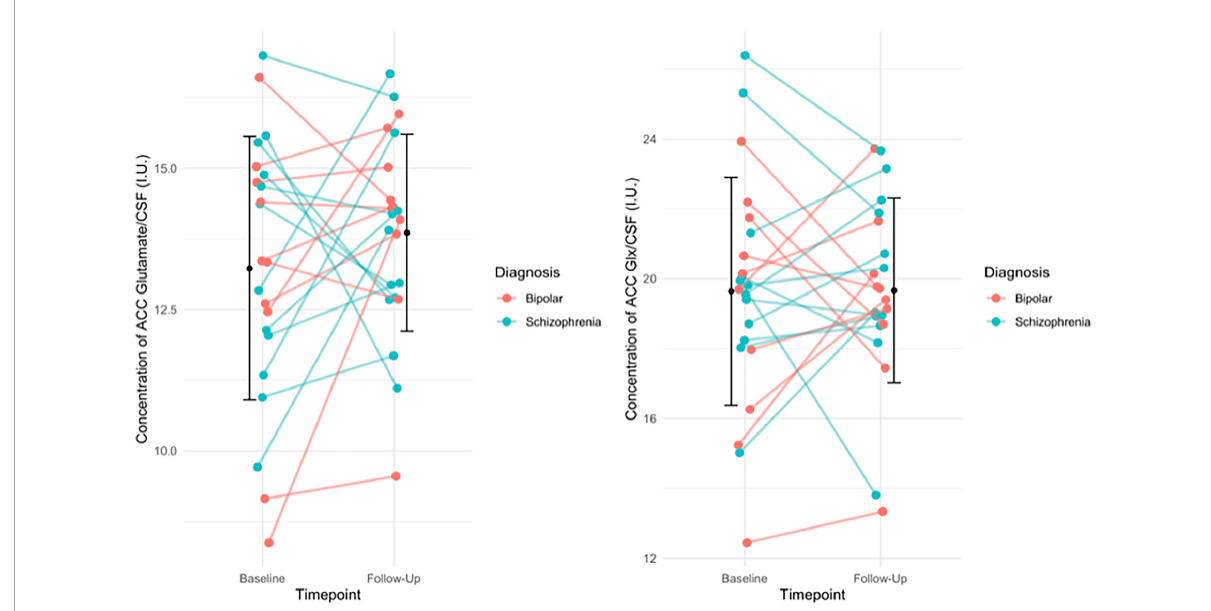
FIGURE1 (Left) The individual change in glutamate levels from baseline to follow-up, with group mean (SD) of glutamate levels at baseline and follow-up (black circle and error bars). Individual change in the figure is stratified by diagnosis. Results of the paired t -test indicated no significant difference in glutamate levels over time ( p = 0.260). (Right) The individual change in Glx levels from baseline to follow-up, with the group mean (SD) Glx levels at baseline and follow-up (black circles and error bars). Individual change in the figure is stratified by diagnosis. Results of the paired t -test indicated no significant difference in Glx levels over time ( p = 0.973).